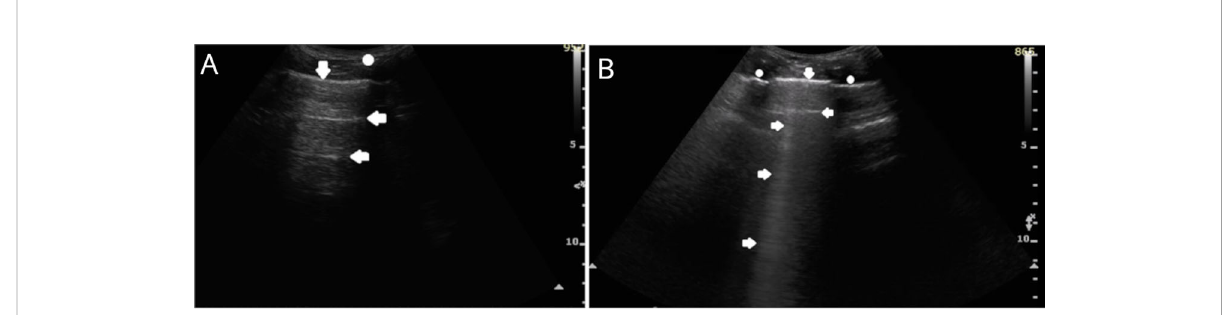
FIGURE 1 Image of normal lung on ultrasonography. (A) structures of chest wall (o), smooth and regular pleural line ( ↓ ), A lines, horizontal artifacts observed in properly aerated lung ( ← ). Convex probe (1-6MHz). (B) ribs and anechoic shadow behind them (o), smooth and regular pleural line ( ↓ ), A line artifact ( ← ), B line, vertical artifact of comet tail, in some objects visible in the last intercostal space as a normal variant ( ! ). Convex probe (1-6MHz).